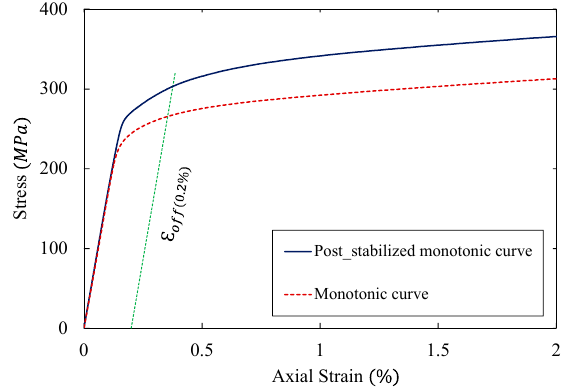
Figure 7. Monotonic and post-stabilized monotonic curves of AISI 316L SS. Figure 6. ( a ) Cyclic hardening behaviour of 316L stainless steel ( b ) stabilized hysteresis curve.